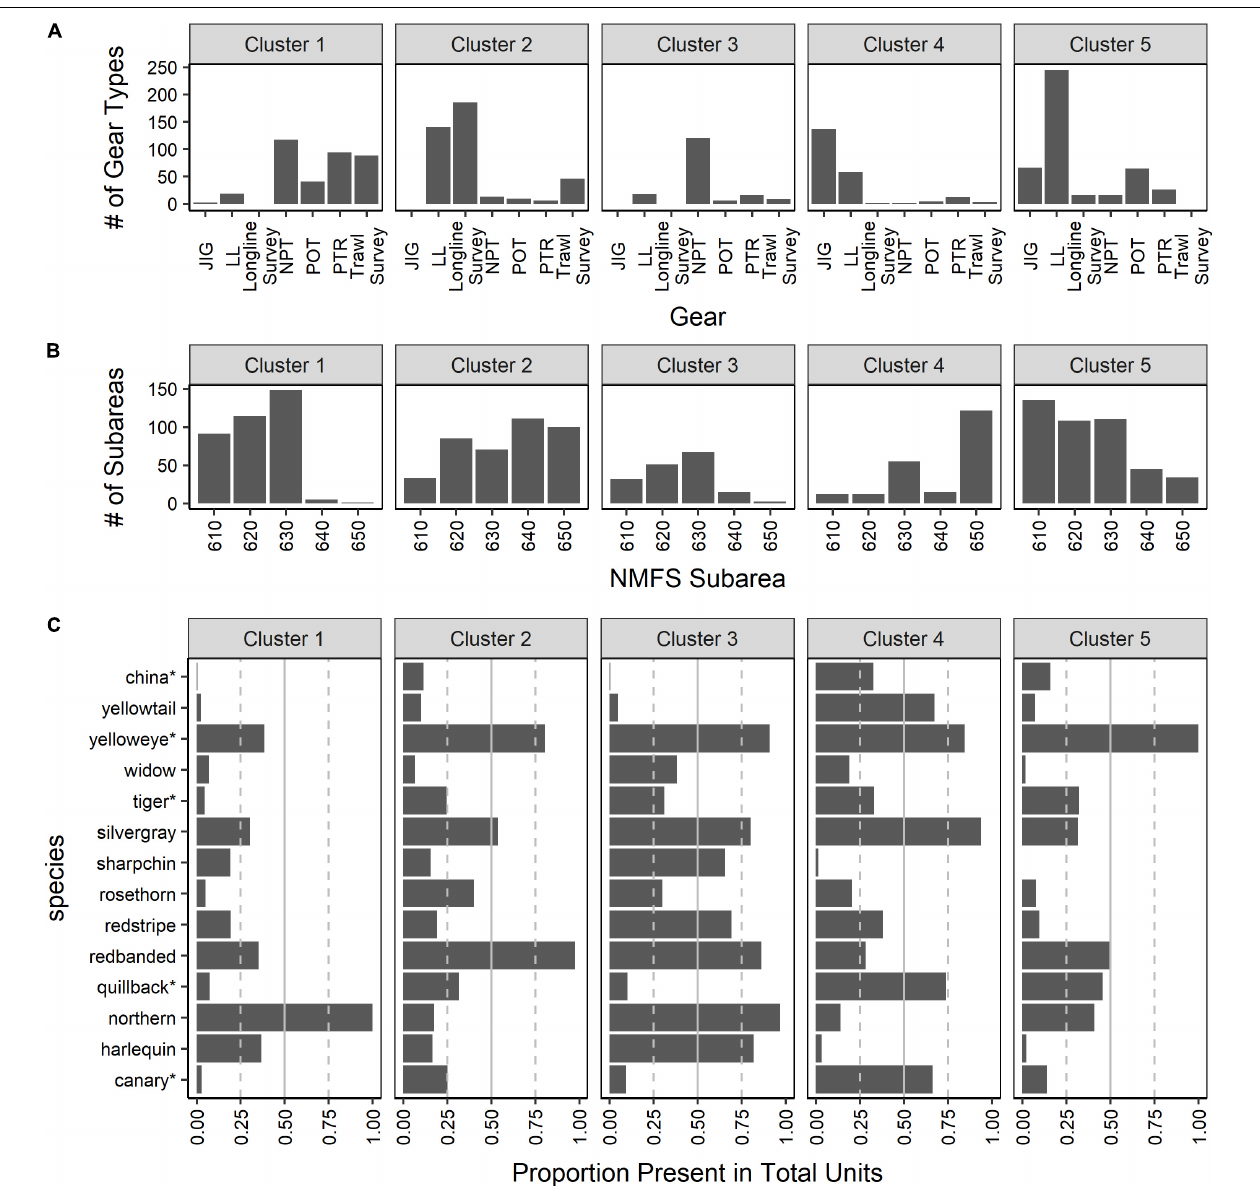
FIGURE 7 | Results from Q-mode k -mediods using the proportions matrix with “units” (year-month-subarea-gear) to synthesize all gear types (fishing gear: jig [JIG], longline hook and line [LL], non-pelagic trawl [NPT], pot [POT], and pelagic trawl [PTR]; and surveys: longline and trawl) and subareas into one dataset when k = 5 clusters. In (A) the number of units where each gear type was present in each cluster is shown. In (B) the number of units where each subarea were present in each cluster is illustrated. In (C) the proportion of units (year-month-subarea-gear) that a species is present out of the total number of units assigned to each cluster is provided to represent the species composition in each suggested cluster when k = 5. Species that currently belong to the Demersal Shelf Rockfish complex are indicated by